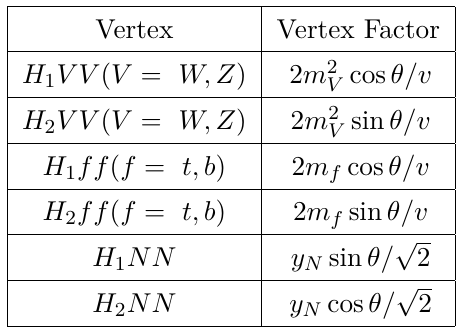
Table 3 . Couplings of SM and BSM Higgs with SM fermions, RHN and gauge